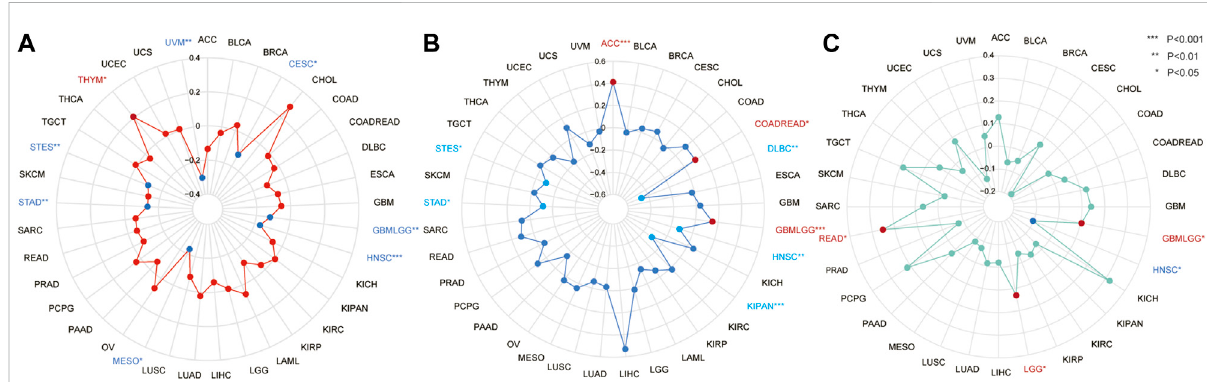
FIGURE 5 ThecorrelationbetweentheexpressionofCSMD2andTMB,MSI,andTNBintumors. (A) ThecorrelationbetweenCSMD2andTMBispositivein THYM and negative in UVM, CESC, GBMLGG, HNSC, MESO, STAD, and STES (B) The correlation between CSMD2 and MSI is positive in ACC, COADREAD, and GBMLGG and negative in DLBC, HNSC, KIPAN, STAD, and STES. (C) The correlation between CSMD2 and TNB is negative in HNSC and positive in GBMLGG, LGG, and READ (*, p < 0.05; **, p < 0.01; ***, p <